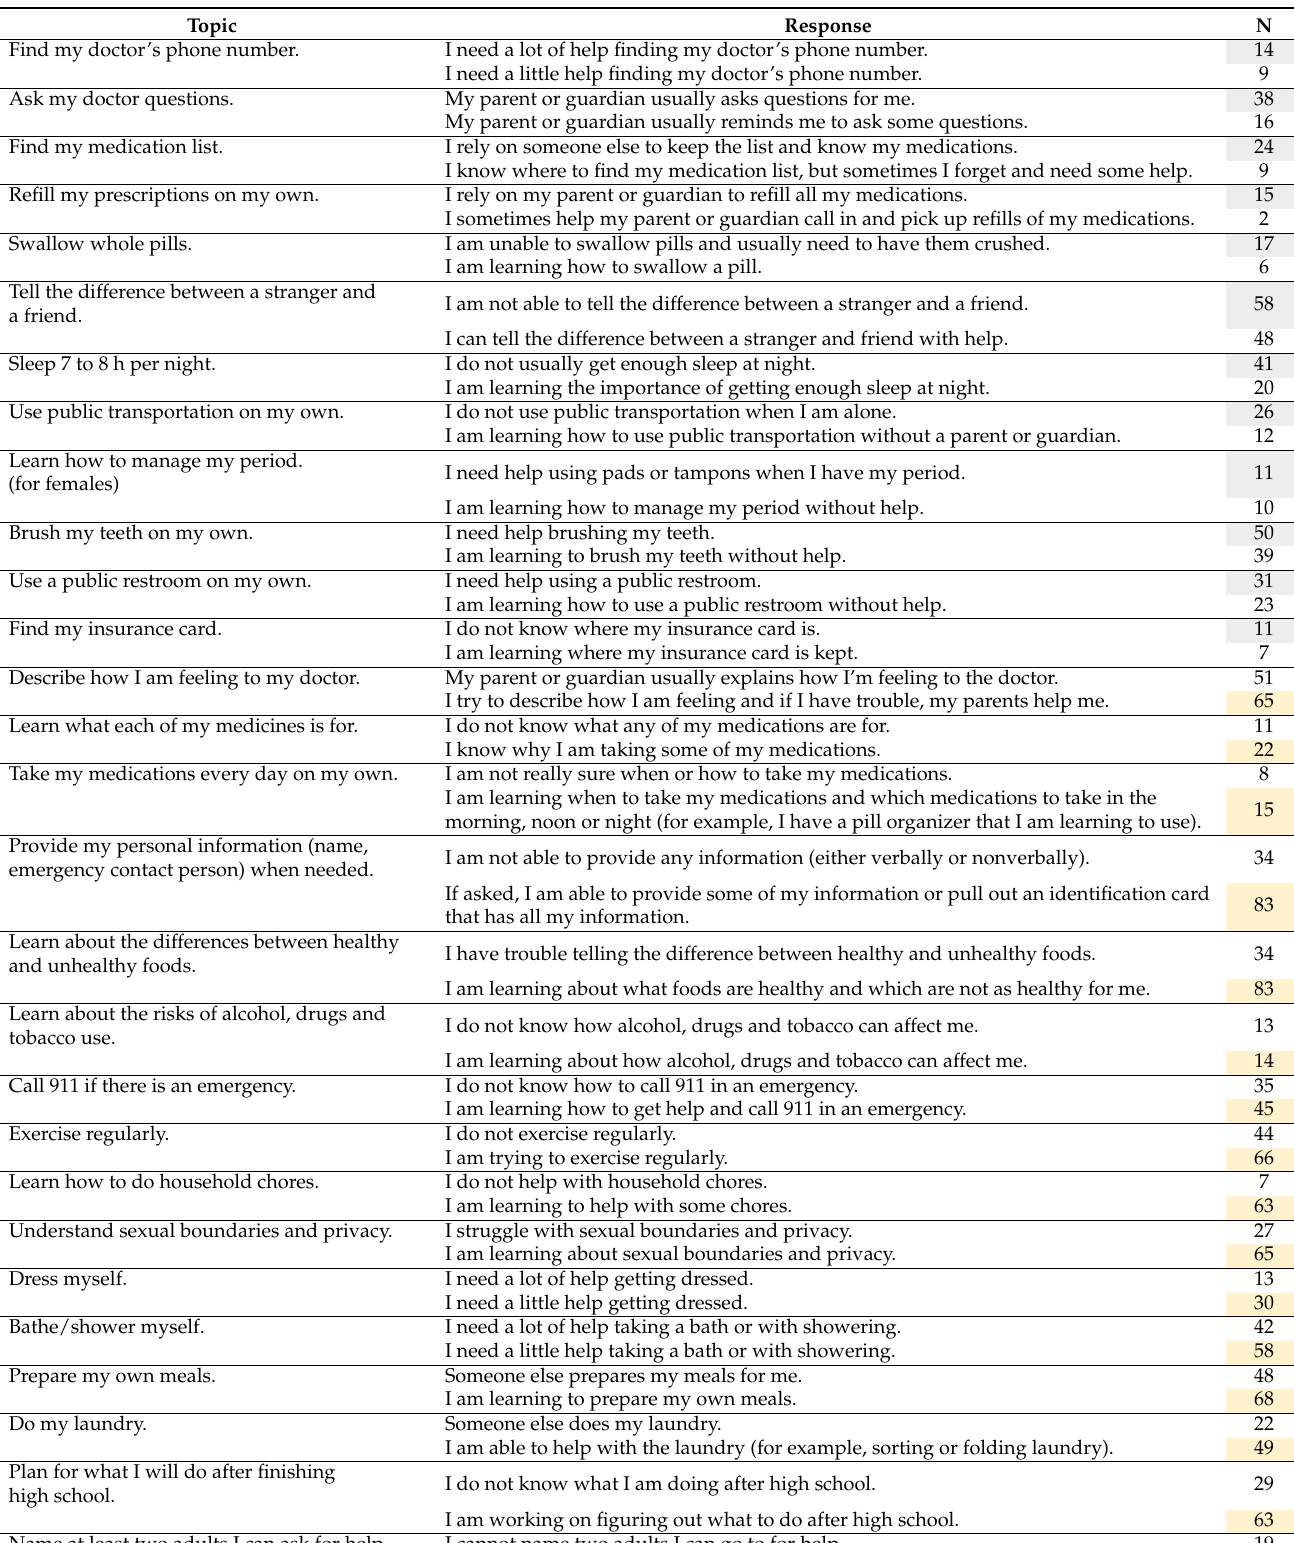
Table 4. Skill level if “This is really important to me now.” This corresponds to Table 3 about individuals with Down syndrome 13+ years in MGH